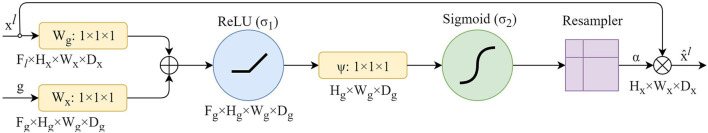
A block diagram of additive attention gate (AG) (Oktay et al., 2018). Input features (xl) are scaled with the attention coefficients (α) computed in AG. Spatial regions are selected by analyzing both the activations and the contextual information provided by the gating signal (g) which is collected from a coarser resolution scale. Attention coefficients are resampled to match the resolution of (xl) by trilinear interpolation.